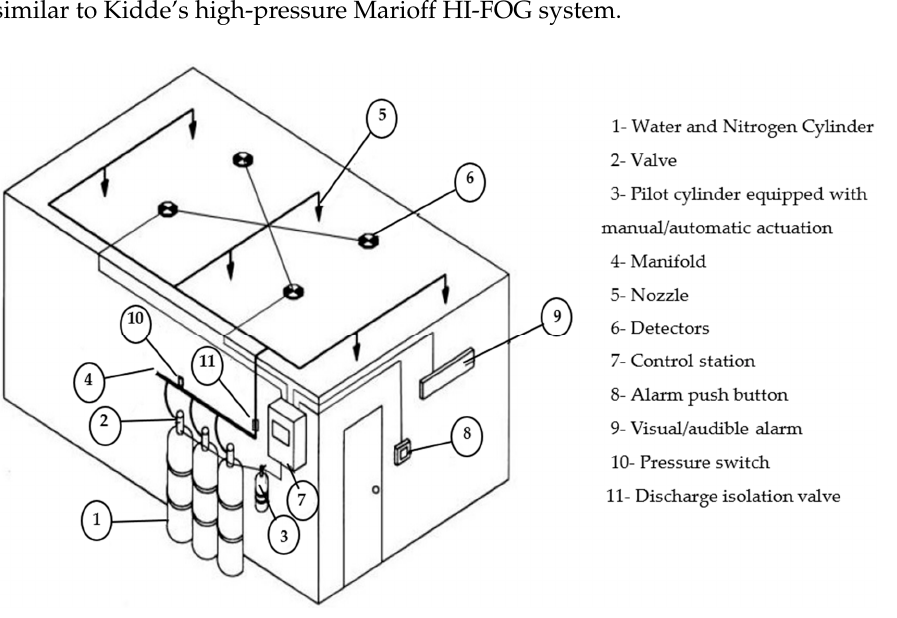
Figure 25. Typical components of an AquaMist FOG stored pressure general arrangement [92]. Marioff HI-FOG